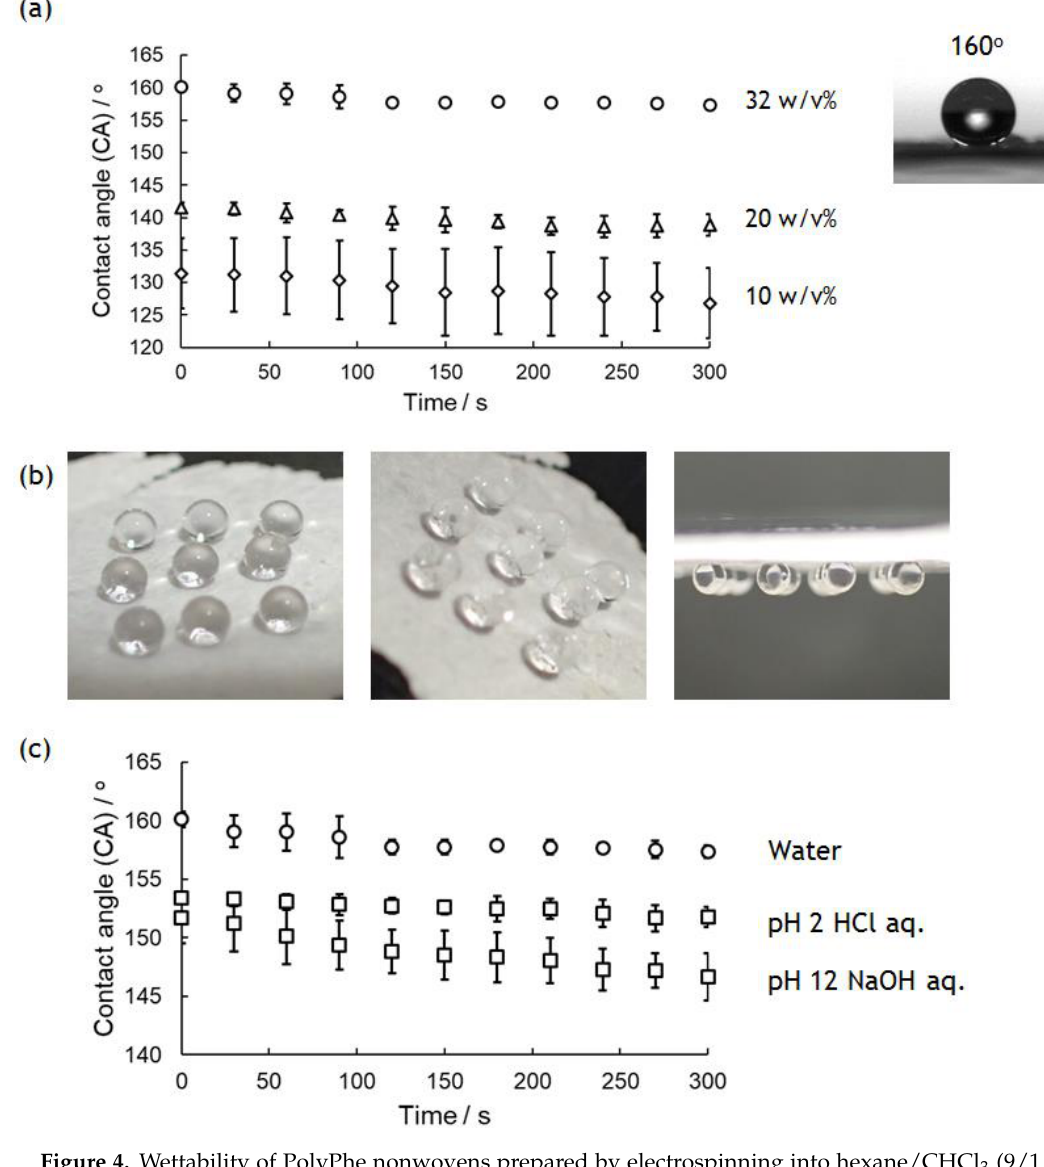
Figure 4. Wettability of PolyPhe nonwovens prepared by electrospinning into hexane/CHCl 3 (9/1 v / v ). ( a ) CA change on PolyPhe nonwovens electrospun at different polymer concentrations ( n = 3). ( b ) Strong adhesion of water droplet onto PolyPhe nonwovens with a tilt angle of 0, 45, and 90°. ( c ) CA change of acidic (pH 2) and basic (pH 12) droplets on the nonwovens (32 w / v %) ( n = 3).